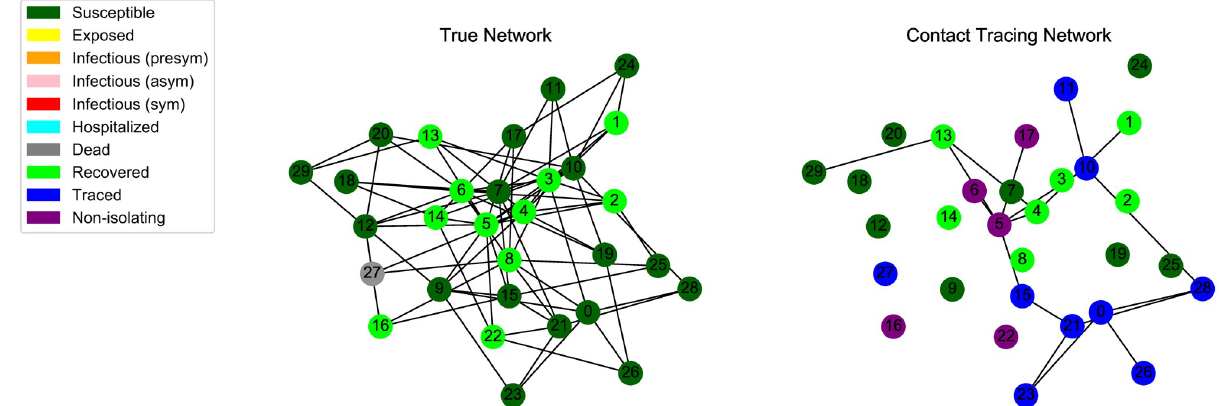
Fig 2. Final state of an epidemic simulation over a dual topology. Infection spreads with respect to the neighborhoods of the first network (here a SF graph); the second network corresponds to digital tracing at uptake r = 0.5.